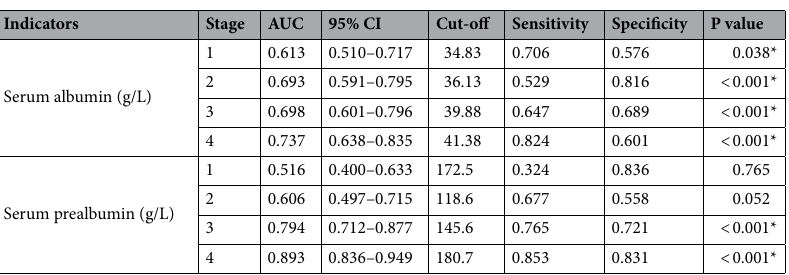
Indicators Stage AUC 95% CI